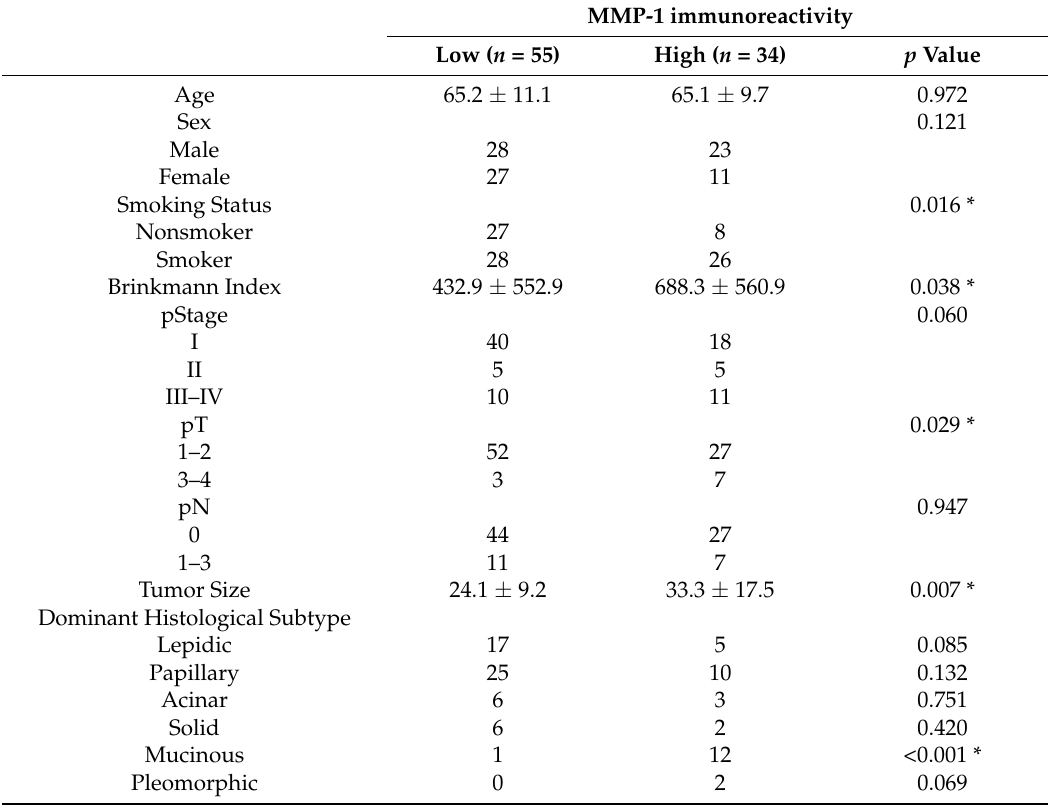
Table 2. Association between MMP-1 immunoreactivity and clinicopathological factors in patients with lung adenocarcinoma ( n =